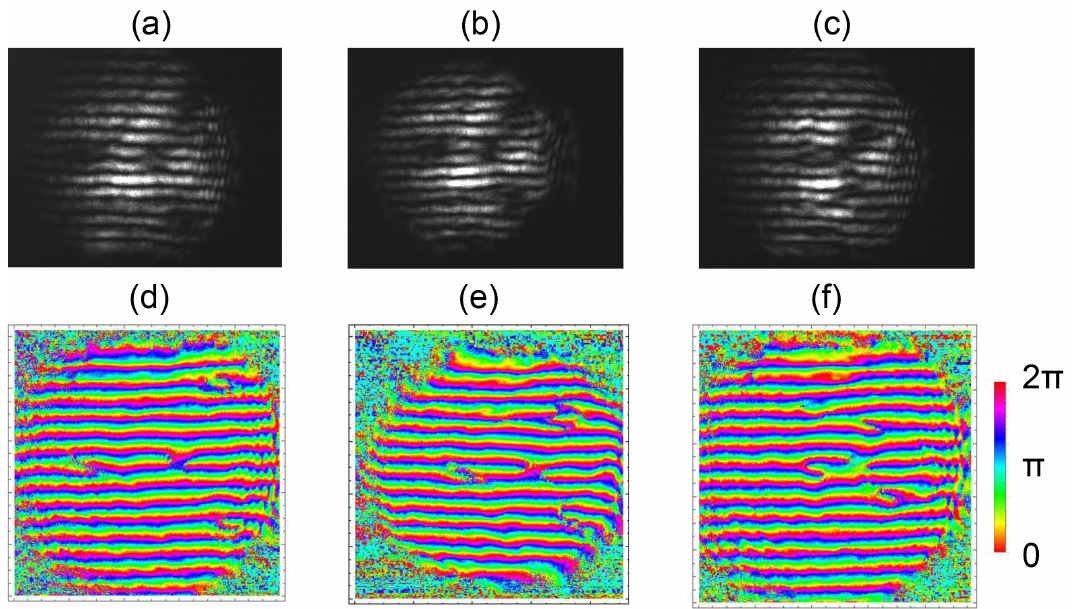
Figure 4. Top row: shear interferograms of the superposition of modes with topological charges (cid:96) = + 1 and (cid:96) = − 2 for several values of β : 35 ◦ in ( a ), 45 ◦ in ( b ) and 60 ◦ in ( c ). Bottom row ( d – f ): 2 1 reconstructions of the phase of the light field corresponding to the shear patterns above them. False color encodes phase.